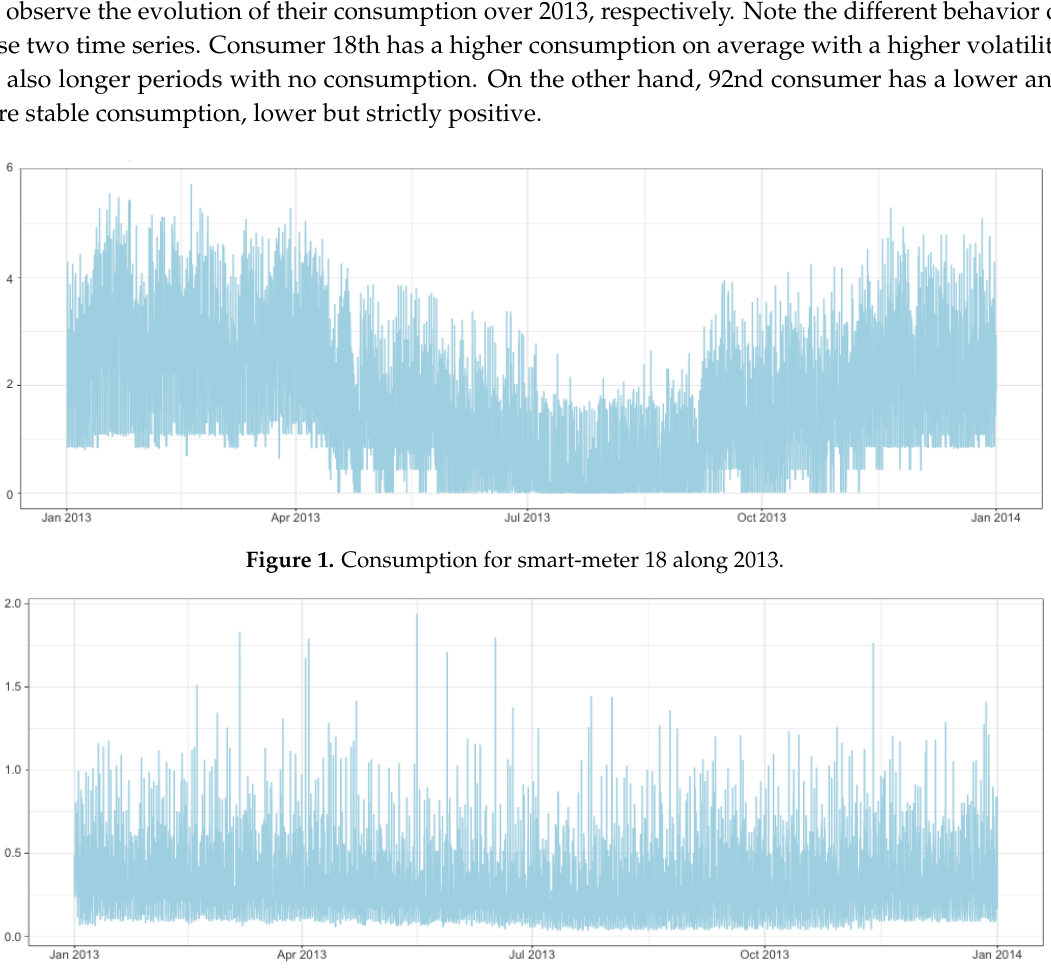
Figure 2. Consumption for smart-meter 92 along